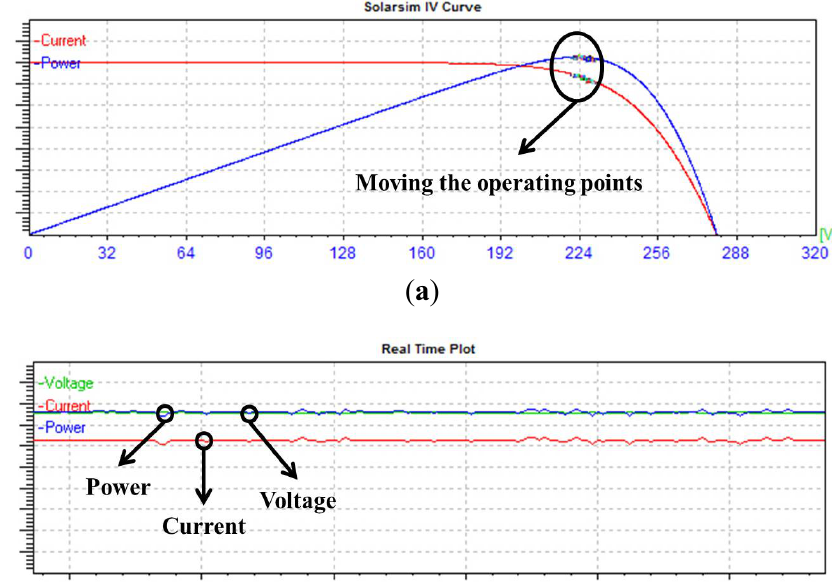
Figure 26. Operating points of PV array after compensation. ( a ) P-V and I-V curve; ( b ) real-time